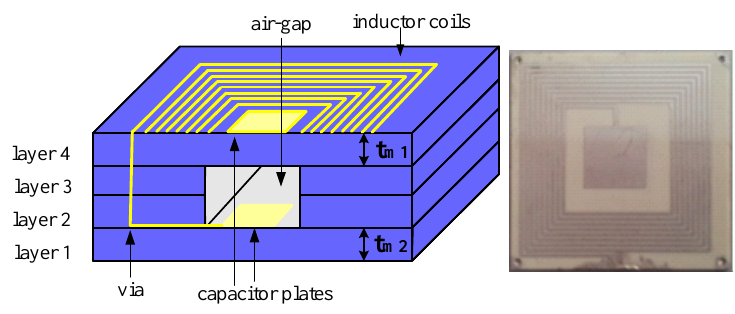
Figure 1. Cross section of sensor and fabricated sensor.